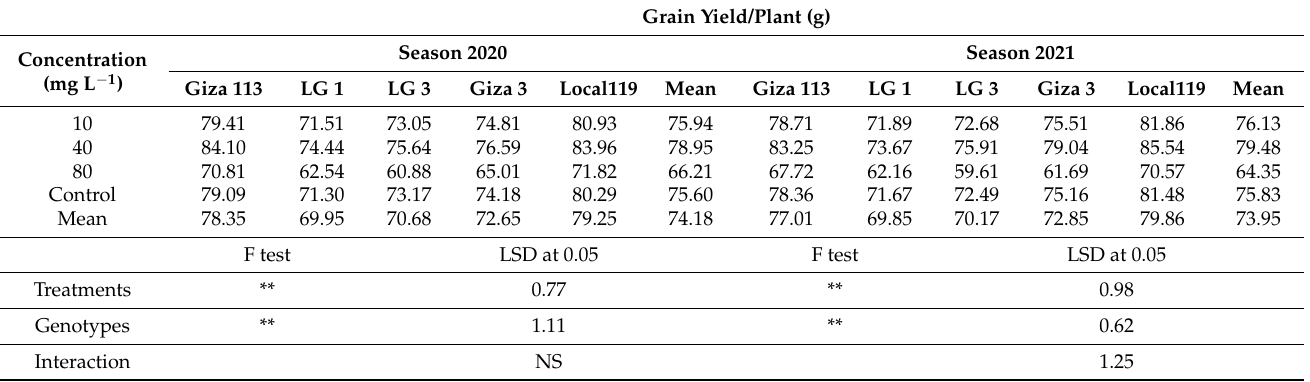
Table 7. Effect of Fe 3 O 4 /HA NPs on the grain yield/ plant for grain sorghum plants during the seasons of 2020 and 2021. Grain Yield/Plant (g)